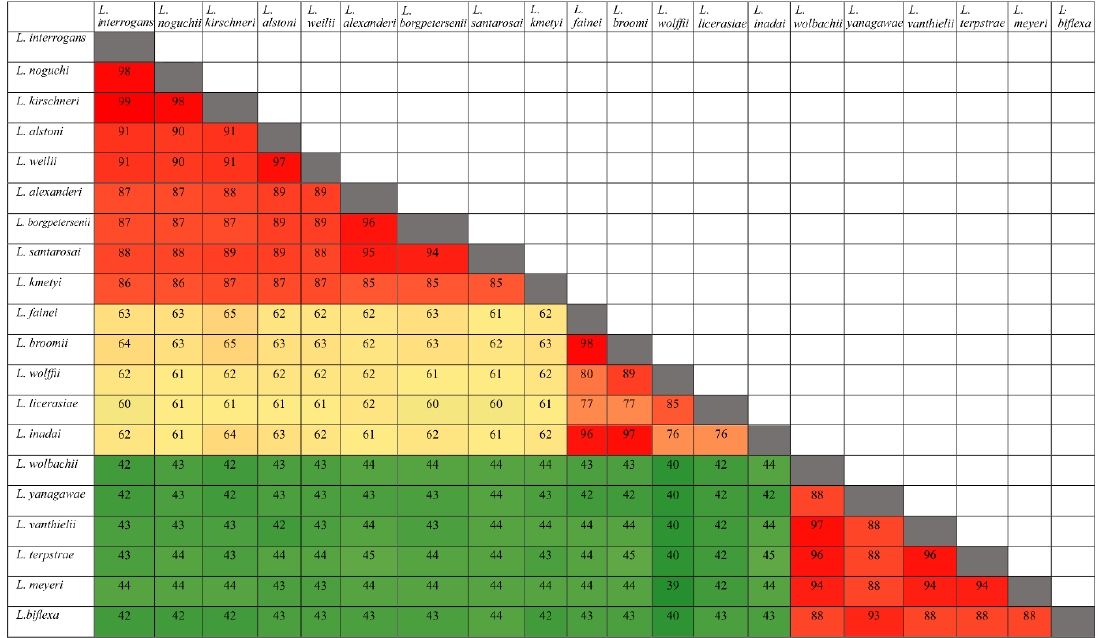
Figure 2. Amino acid sequence identities of LIC11112 from 20 different Leptospira strains. The image was generated comparing the sequence of the protein encoded by LIC11112 from L. interrogans serovar Copenhageni with other 20 species (pathogenic, intermediate, and saprophytic). Similarity is shown in red above 80%, in yellow between 50% and 80% and in green below 50%.